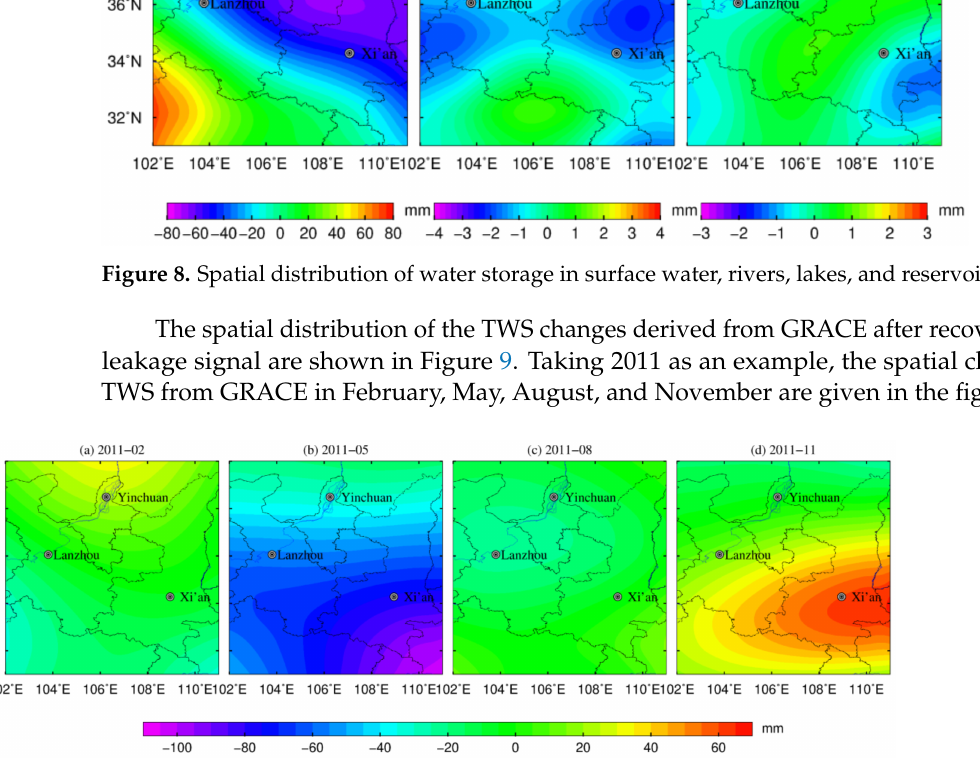
Figure 9. Spatial distribution of regional TWS variations derived from